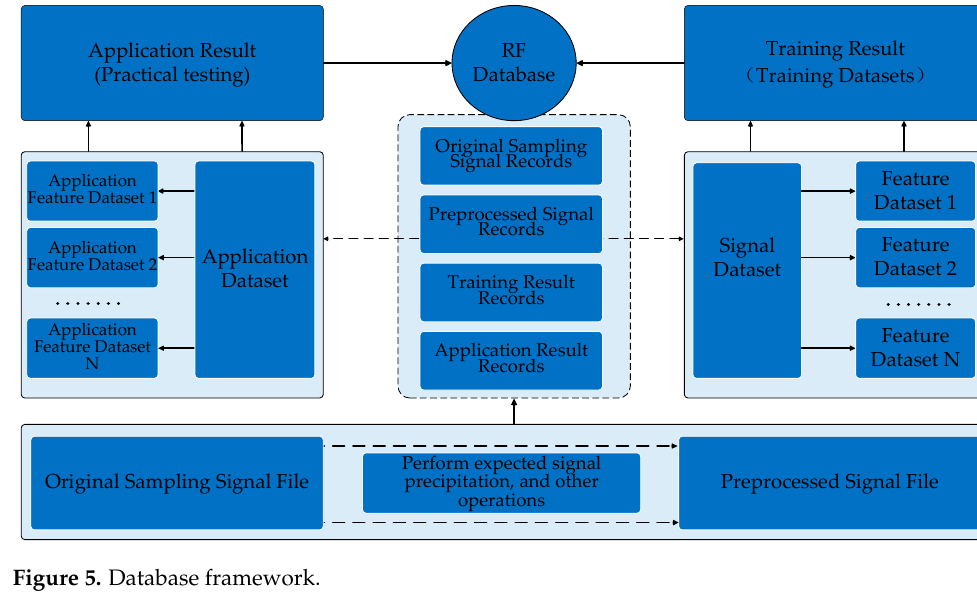
Figure 5. Database framework.